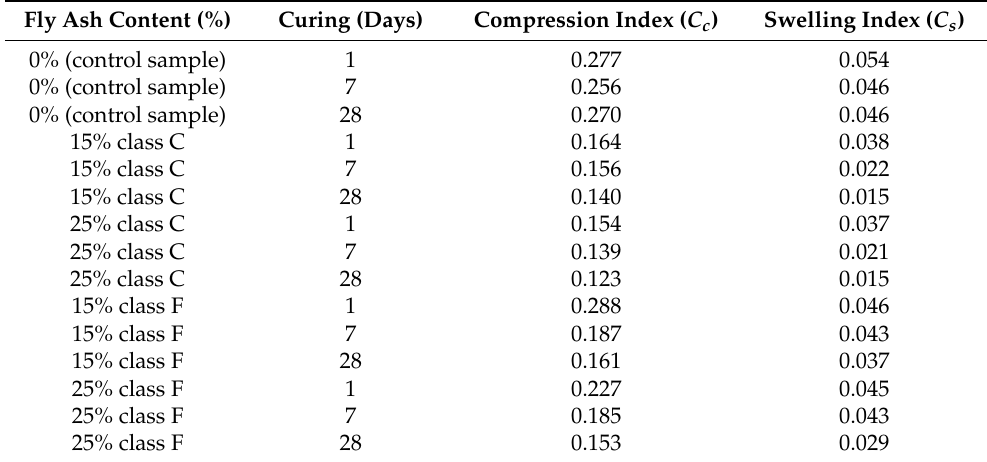
Table 5. Effects of fly ash and curing time on compression and swelling